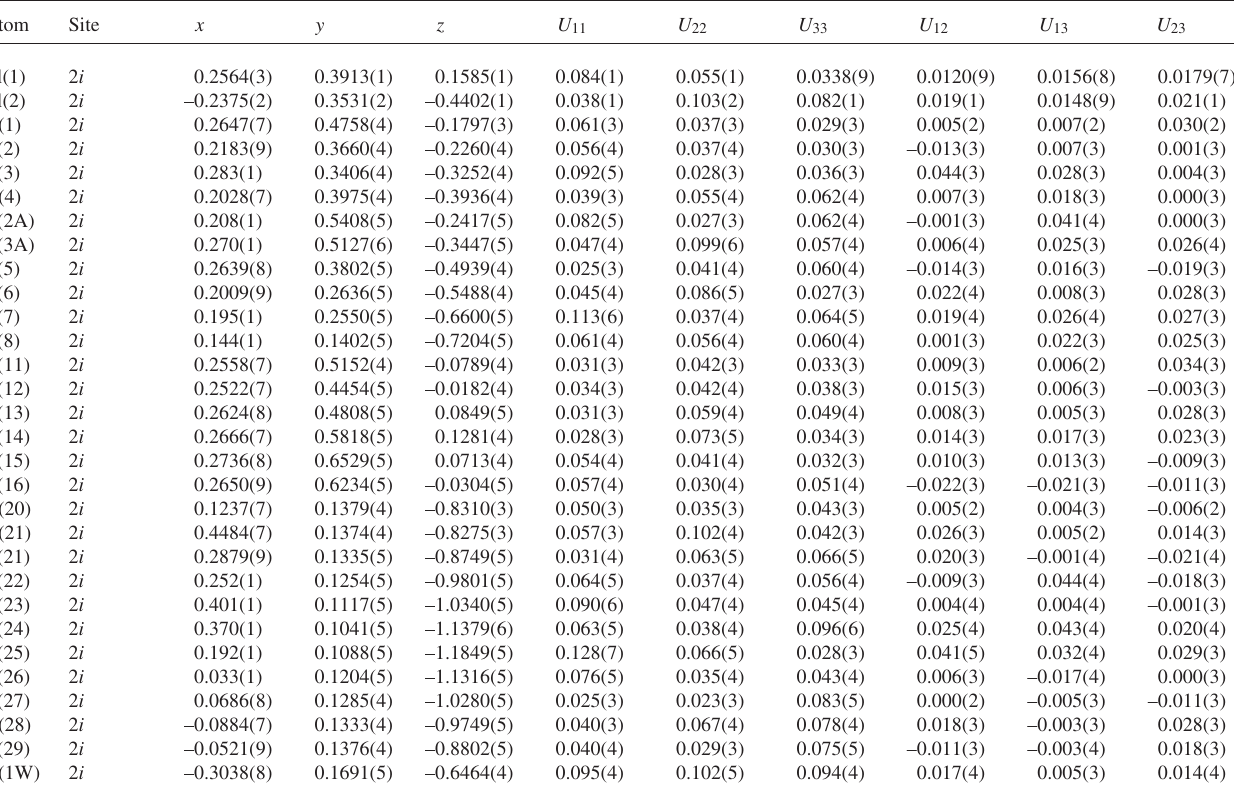
Table 3. Atomic coordinates and displacement parameters (in Å 2 ) .